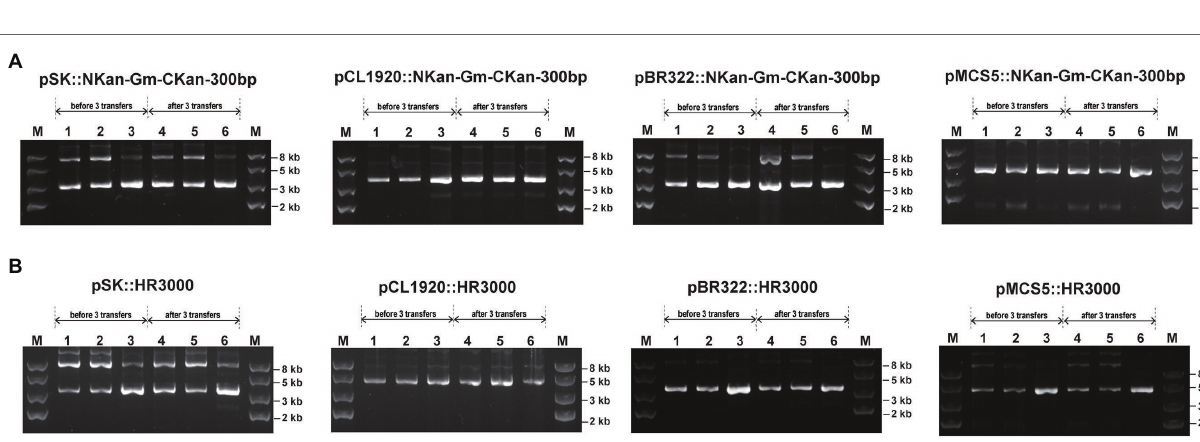
FIGURE 7 | The stability of plasmids with homology features after extended culturing for 3 transfers. Three transformants were randomly selected from plates and cultured in LB medium for 3 transfers, representing about 60 generations. The plasmids were then extracted and checked via gel electrophoresis. (A) NKan-Gm- CKan-300 bp was assembled into four vectors. (B) HR300 was assembled into four vectors. Lanes 1–3 in each figure represent plasmids extracted from three cultures before 3 transfers, and lanes 4–6 in each figure represent plasmids extracted from three cultures after 3 transfers. Lane 1–2 and 4–5 represent plasmids extracted from strain BW25113, and Lane 3 and 6 represent plasmids extracted from strain XL1-Blue